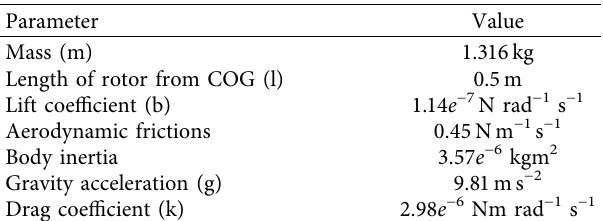
Figure 2: LabVIEW block diagram of SIL simulation. Table 3: Model